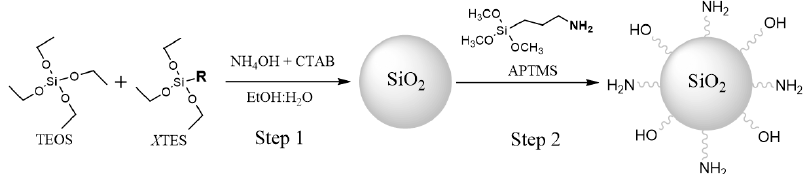
Figure 1. Synthesis of the Ormosil nanoparticles by modified Stöber method with di ff erent silica sources (MTES: triethoxymehylsilane, VTES: triethoxyvinylsilane, PTES: phenyltriethoxysilane, and OTES: triethoxy(octyl)silane).